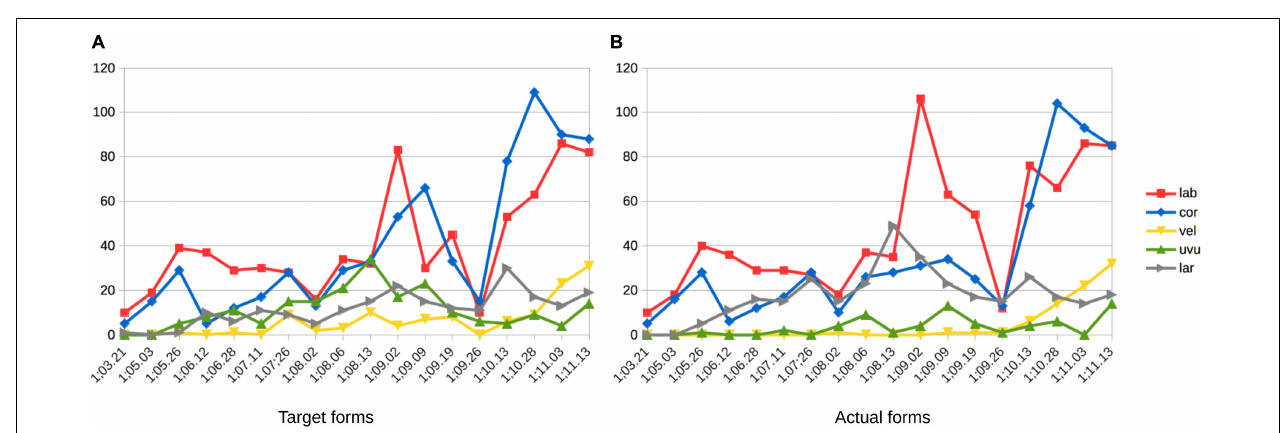
FIGURE 6 | Wiglaf’s attempted word types, by initial sounds.